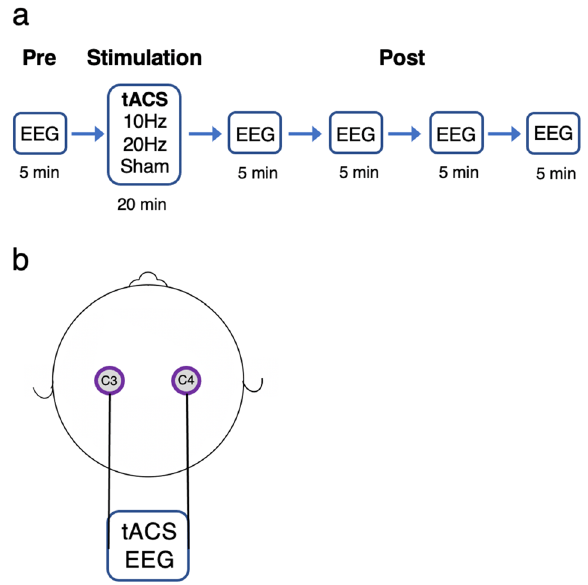
Figure 4. Experimental design. ( a ) Five minutes of resting-state EEG were acquired before tACS. Immediately following the end of stimulation, resting-state EEG was recorded for an additional 20 min ( b ) Stimulating and recording electrodes were positioned over C3 and